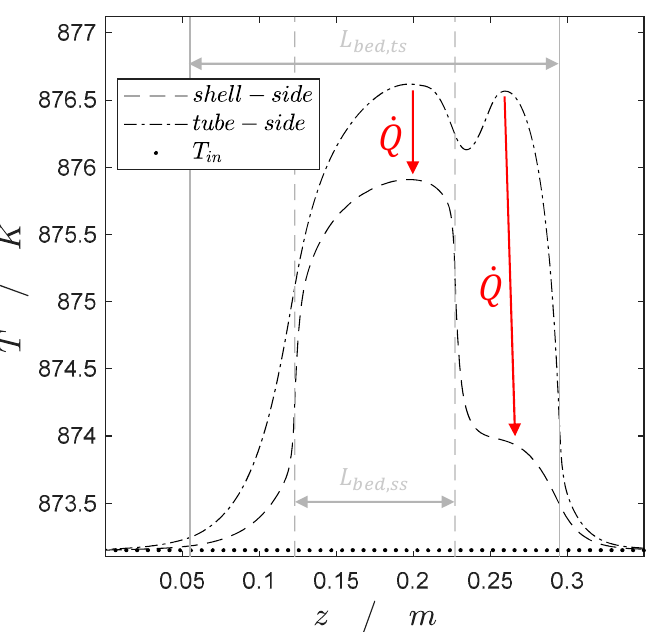
Figure 8. Hot spot positions in the PBMRint in dependency of time during deactivation ( x C T W = T in = 600 ◦ C; WHSV = 400 kg · s · m − 3 ).